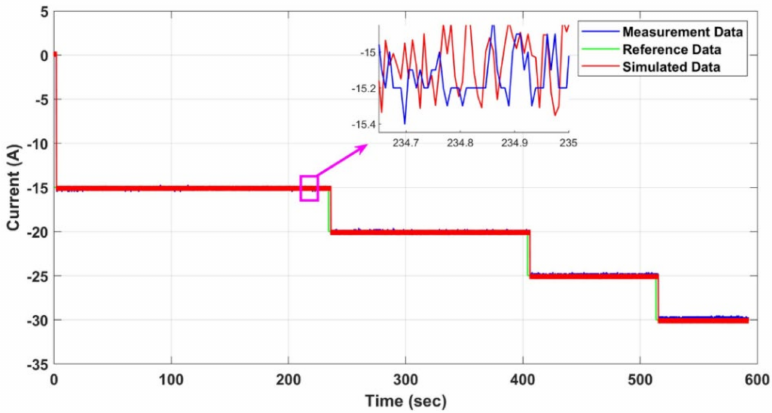
Figure 23. Simulation model results compared to the reference and actual hardware measurement data.